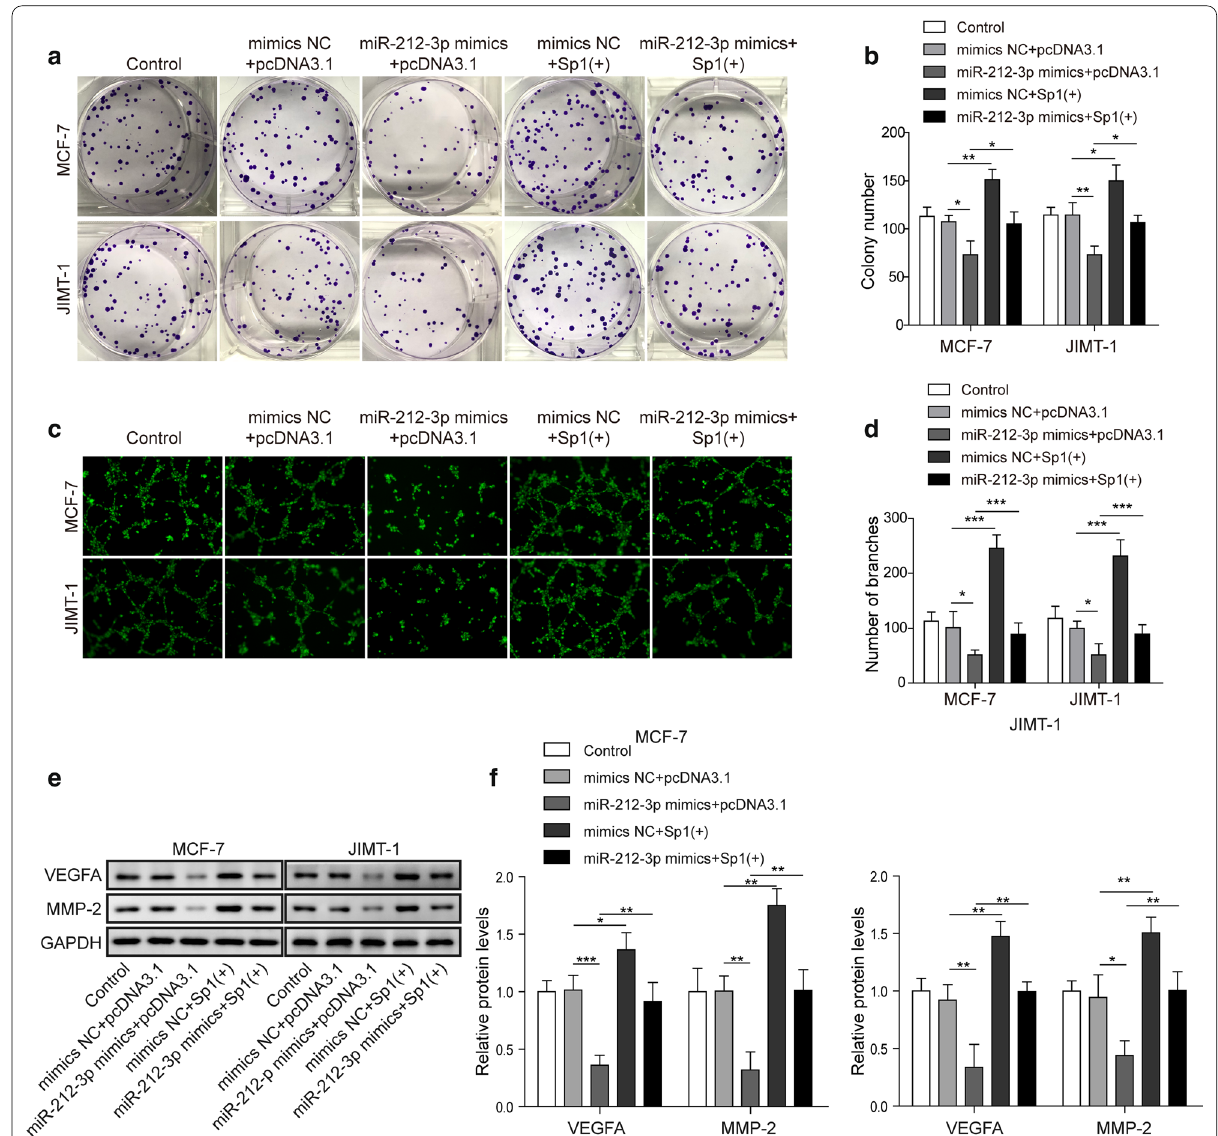
Fig. 5 MiR‑212‑3p inhibited the proliferation and angiogenesis of BC cells by reducing the expression of VEGFA through SP1. a , b Proliferation ability of MCF‑7 and JIMT‑1 was detected by clone formation assay in cells transfected with miR‑212‑3p mimics and Sp1 ( MCF‑7 and JIMT‑1 cells transfected with miR‑212‑3p mimics and Sp1 ( ). Relative intensity of bands of each protein were normalized to loading + control GAPDH. * P < 0.05, ** P < 0.01, *** P <